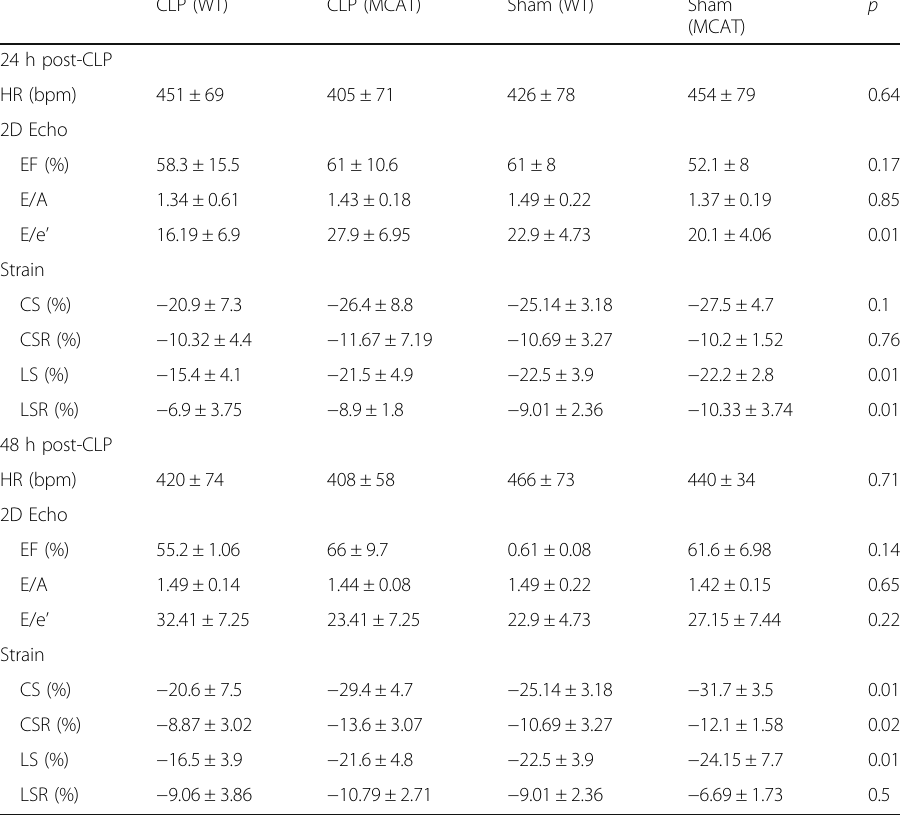
Table 4 MCAT and Wildtype Mice Echocardiographic Metrics at 24 and 48 h post-CLP CLP (WT) CLP (MCAT) Sham (WT) Sham